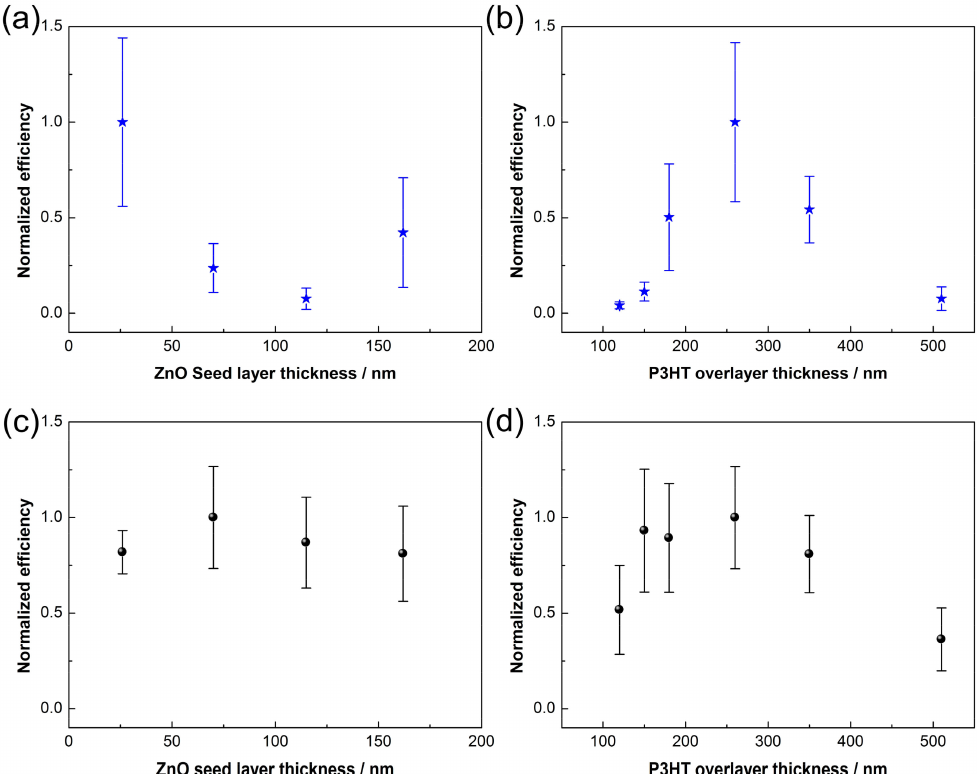
Figure 8. Normalized PCE as a function of the thickness of ETL and HTL for ( a , b ) unmodified devices and for ( c , d ) C60 modified devices.